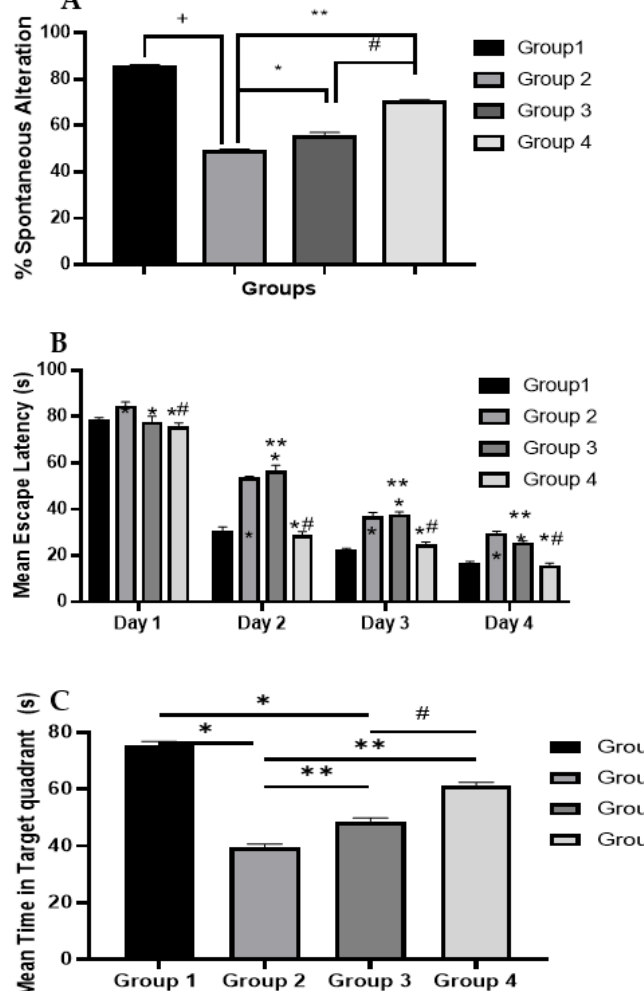
Figure 4. Behavioral assessment of the effect of ART on ( A ) the percentage of spontaneous alterna- tion, ( B ) mean escape latency in MWM and ( C ) time spent in target quadrant in MWM. Statistical analyses are performed using one-way analysis of variance (ANOVA) followed by Tukey post-hoc test. +: Statistically significant different from the normal control group (Saline) at p < 0.05, * and **: Statistically significant different from the positive control group (STZ, 3 mg/kg) at p < 0.05, #: Statis- tically significant different from the ART group (50 mg/kg) at p < 0.05. ART-Nanoparticles (equivalent to 50 mg/kg).